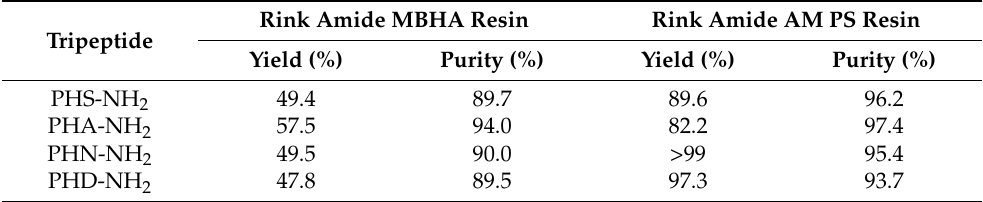
Table 1. Yields and purities of the representative tripeptides (PHX-NH 2 ) synthesized using Rink amide MBHA resin and Rink amide AM PS resin. Tripeptide Rink Amide MBHA